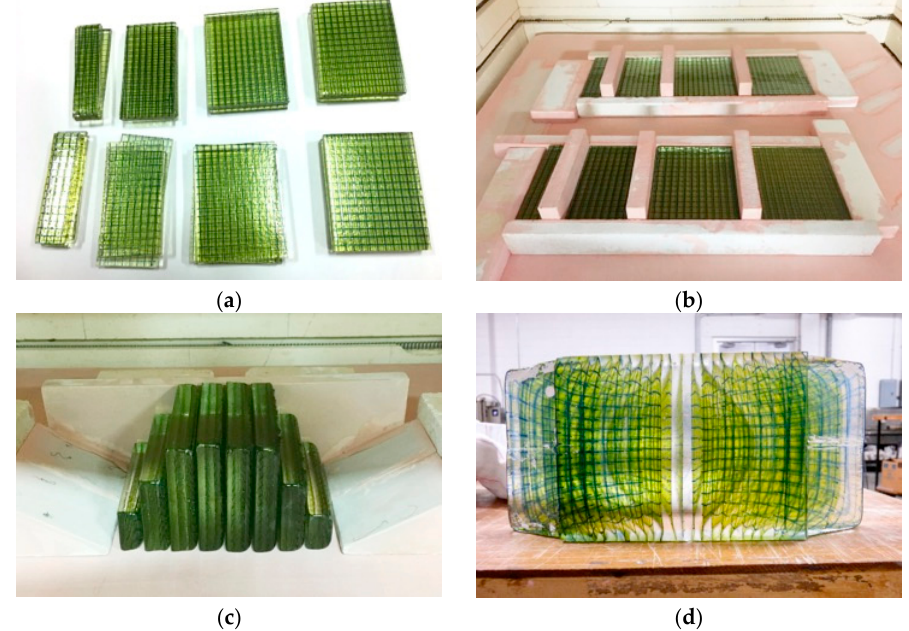
Figure 4. Process for ‘graphic swim’ test blocks. Glass screenprinted with a grid pattern ( a ) is stacked and fused into sections ( b ), which are then set on edge ( c ) for a second fusing cycle. Resulting fusing exposes movement of imagery ( d ). Photos: The Author and Bullseye Glass Co.